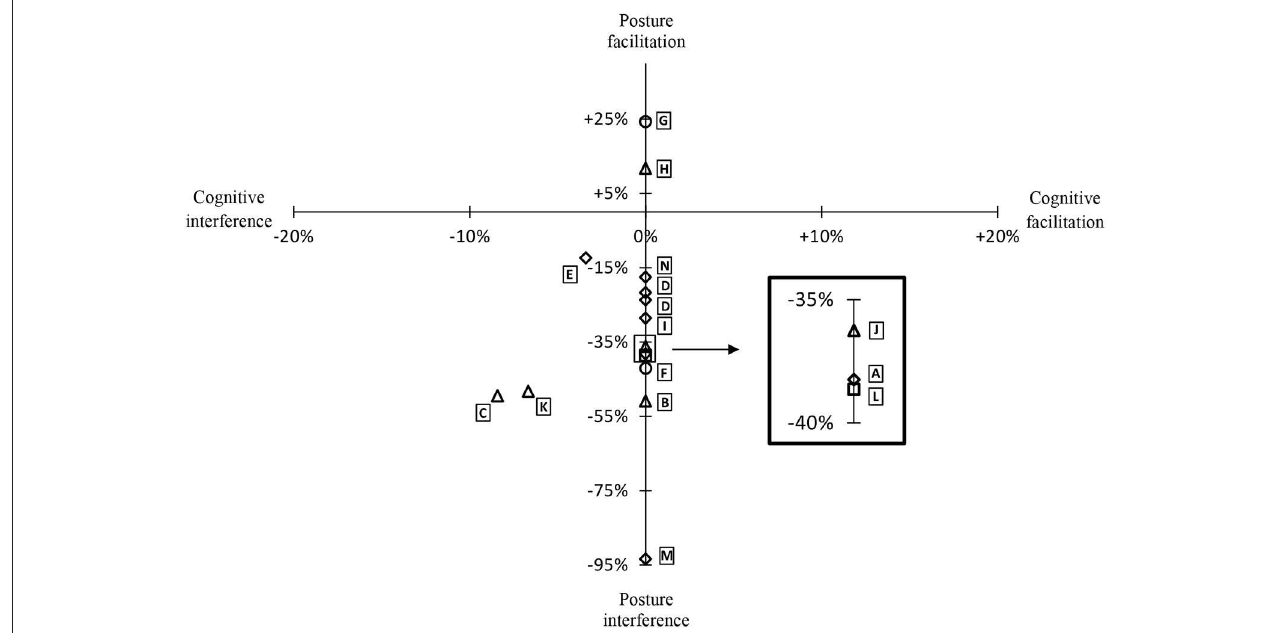
FIGURE 2 | Graphical representation of the DTC (MS subjects) for the included studies of the review. Prioritization instructions: ♦ , No instructions, (cid:3) , Posture, △ , Cognition, ◦ , Both tasks. The DTC from de study of Datolla et al. ( 20) (D) are represented by two points for the semantic and phonetic fluency